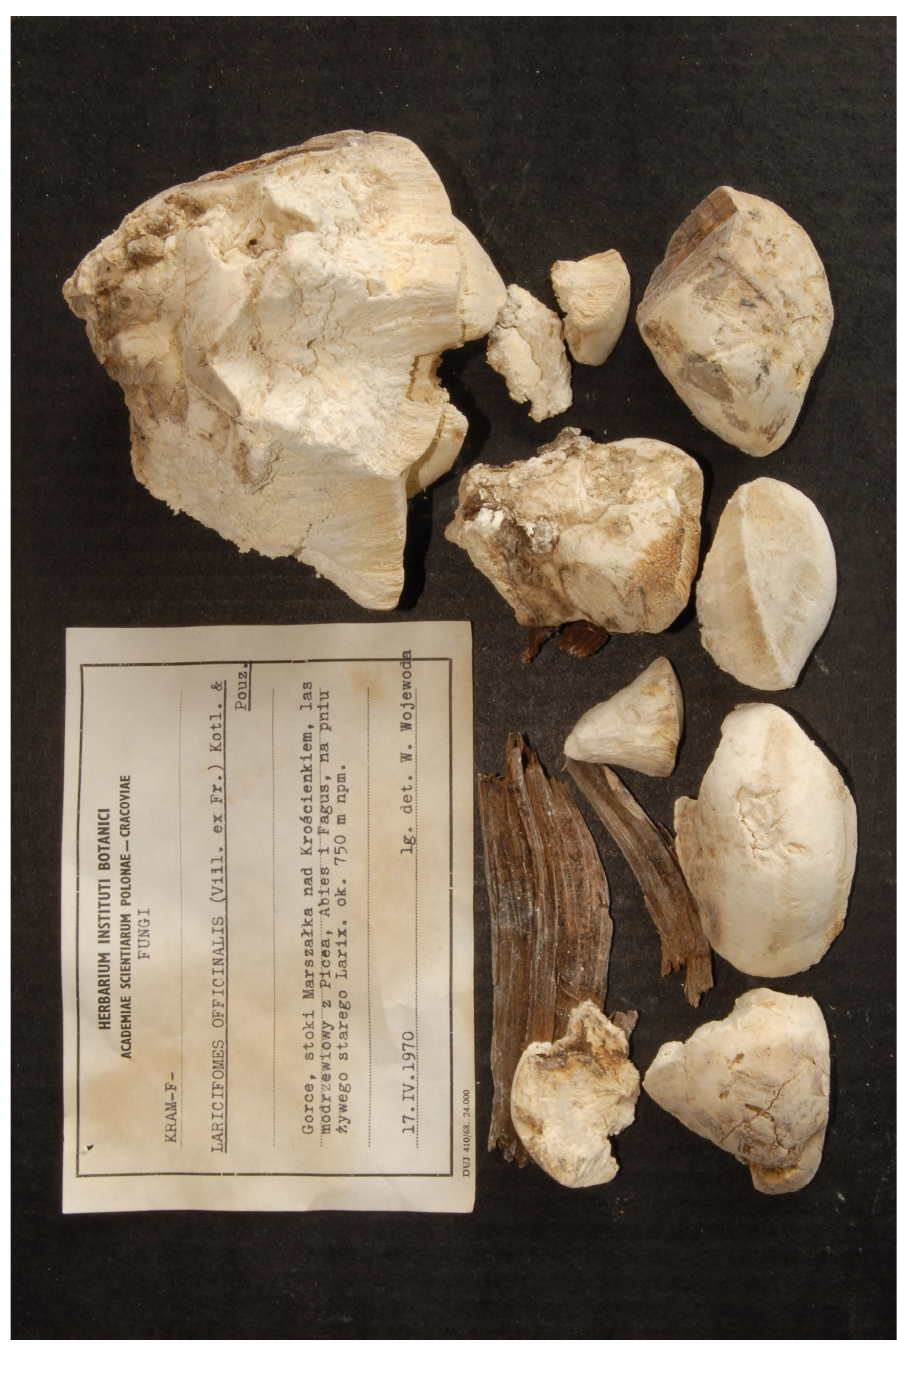
Fig. 1. Laricifomes officinalis preserved in the Herbarium KRAM F of the W. Szafer Institute of Botany, Polish Academy of Sciences in